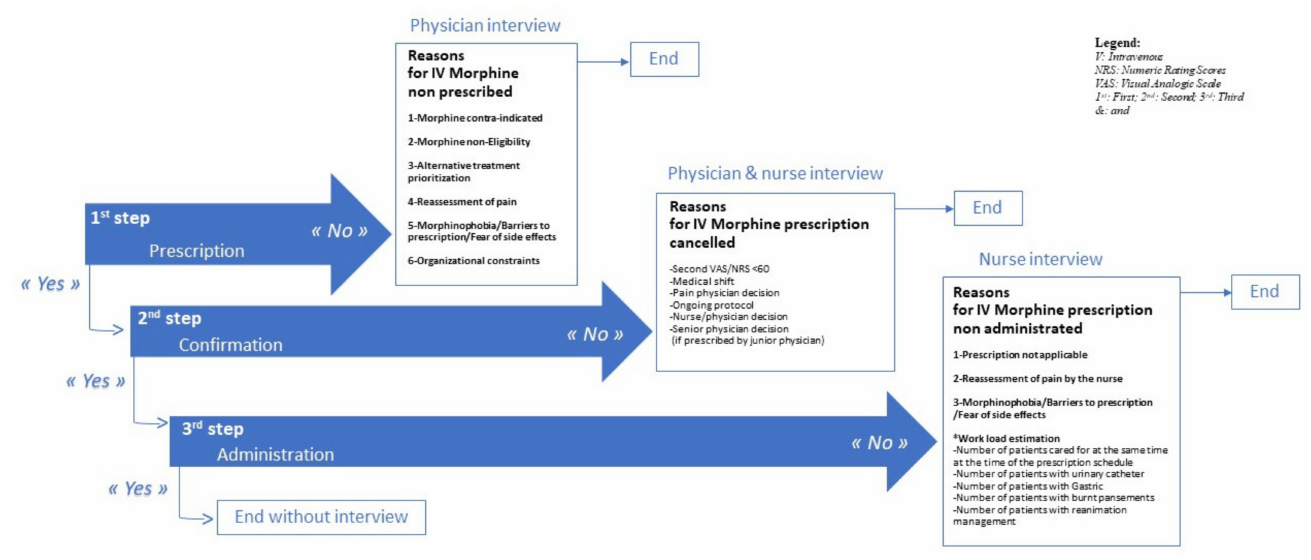
Figure 2. The 1 to 3-step caregivers’ interview: patterns and